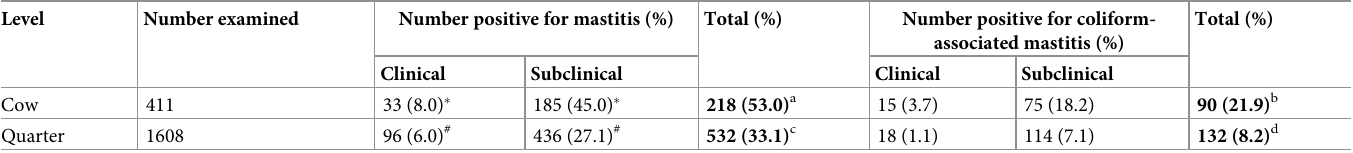
Table 2. Prevalence of mastitis and coliform-associated mastitis in North West Cameroon.